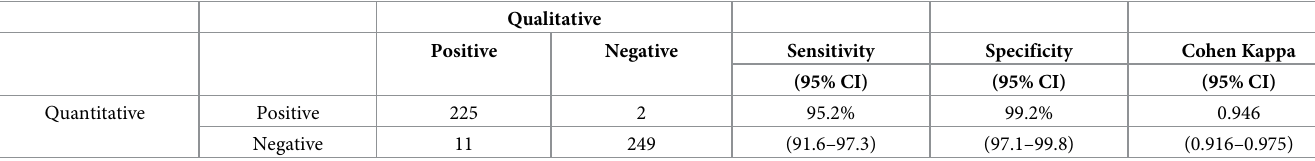
Table 4. Performance of the Abbott viral load test compared to the Roche qualitative